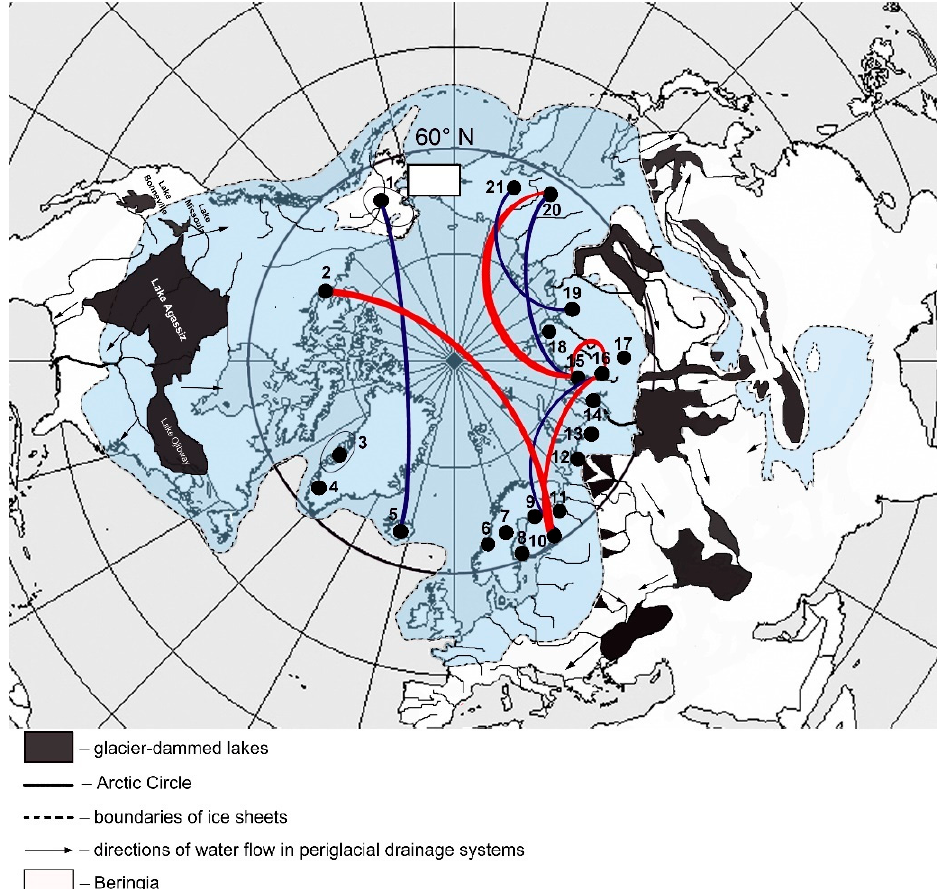
Figure 7. Circumpolar freshwater network. Distribution of ice sheets during maximum glaciation according to M.G. Grosswald (2009) [47] and of ice ‐ dammed lakes throughout their existence and migration according to Thorleifson (1996) [84], Grosswald (1999) [45], Teller et al. (2005) [85], Rudoy (2008) [86], Rudoy and Zemtsov (2010) [87], Rudoy, (2011) [88], Michalek (2013) [89] and Lepper et al. (2013) [90]. The blue and red lines correspond to clustering of regions similar in representation status of the species shown in Figure 5. The map was generated using the free software QGis v. 3.14.16 and edited in free image editor GIMP 2.10.0.